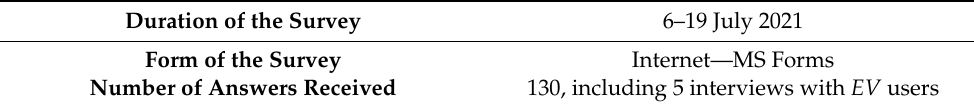
Table 1. Basic information about the